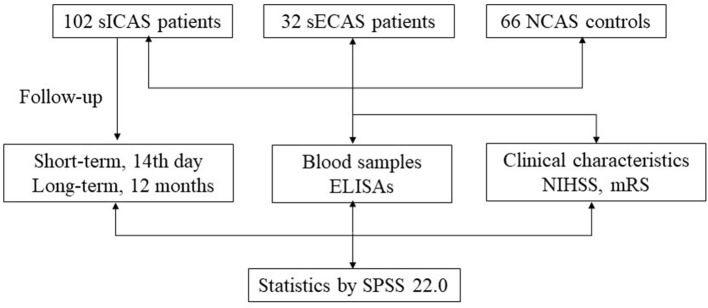
Study flow chart. sICAS, symptomatic intracranial atherosclerotic stenosis disease; sECAS, symptomatic extracranial atherosclerotic stenosis disease; NCAS, no atherosclerotic stenosis controls; NIHSS, National Institutes of Health Stroke Scale; mRS, modified Rankin Scale; ELISA, enzyme-linked immunosorbent assay.